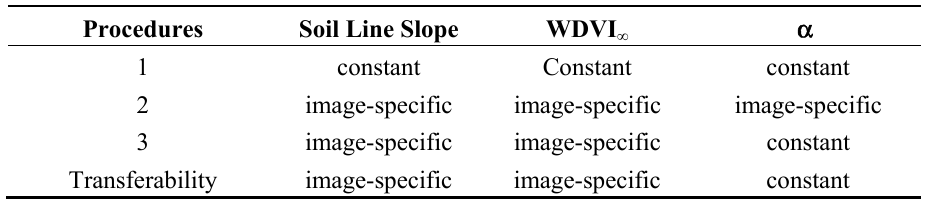
Table 1. Summary of the three procedures to derive the CLAIR model parameters. The ‘soil line slope’ represents the slope of the linear relationship between red and near-infrared reflectance of bare soil pixels. The WDVI is the asymptotically limiting value for the ∞ Weighted Difference Vegetation Index (WDVI) when LAI tends to infinity and α is the extinction and scattering coefficient of the CLAIR model. A fourth procedure consisted in transferring the model parameters from one test site to